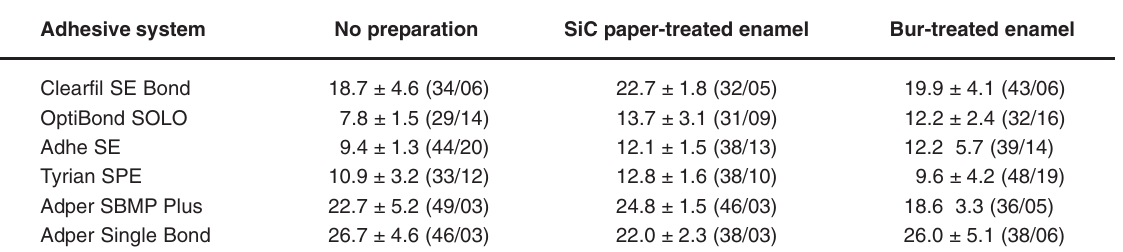
TABLE 1- Bond strength indexes in MPa (means ± standard deviations). Number of tested sticks and prematurely debonded sticks Adhesive system